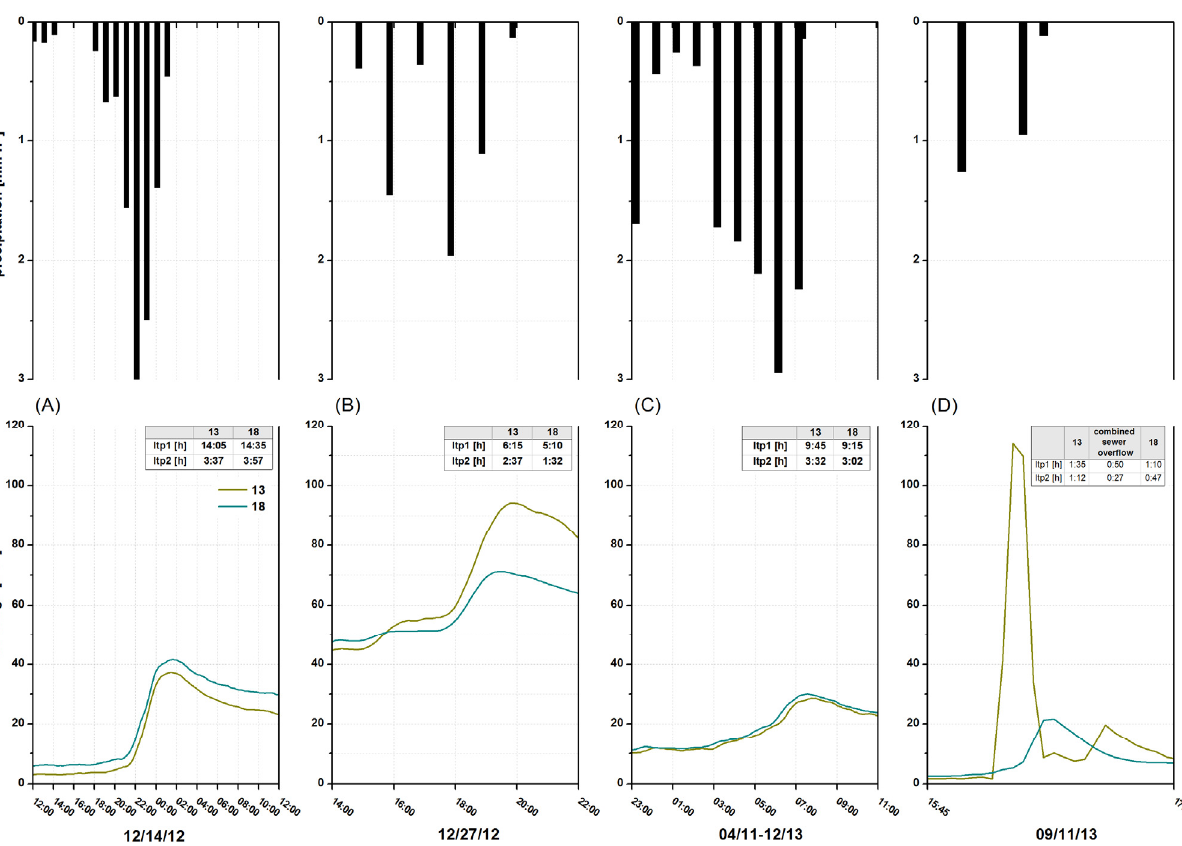
Figure 5. Time series of precipitation (L·s − 1 ) and discharge (L·s − 1 ) depicted